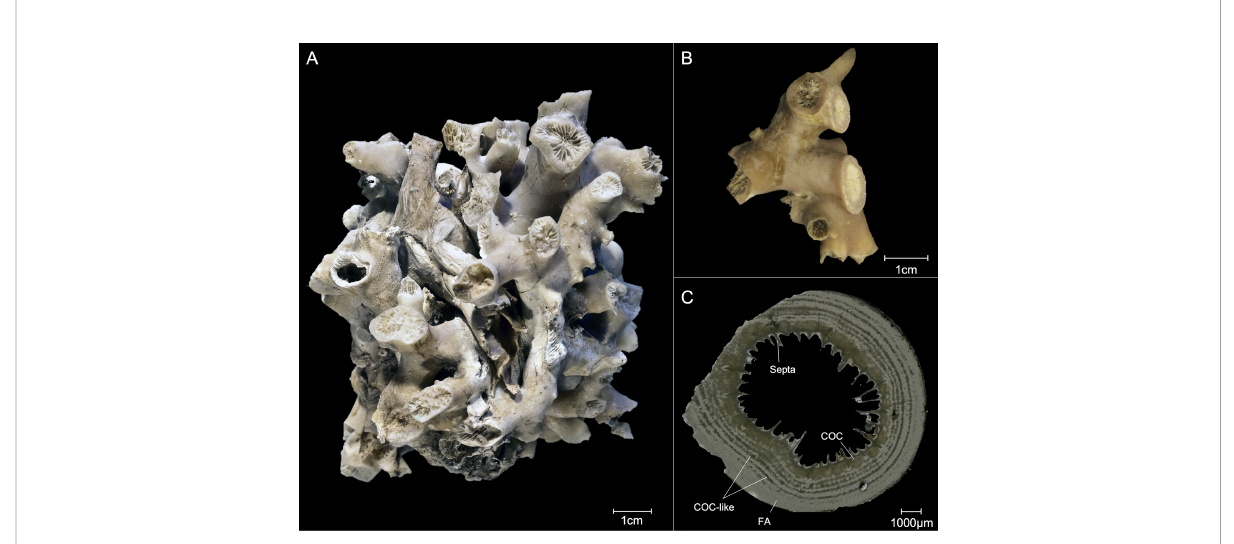
FIGURE 2 Different representations of the coral samples of S. variabilis: (A) Live picked sample in the Paci fi c near New Zealand. (B) Fossil sample of the Bowie Mound in AAIW and (C) cross section of a fossil sample; COC, center of Calci fi cation; FA, Fibrous